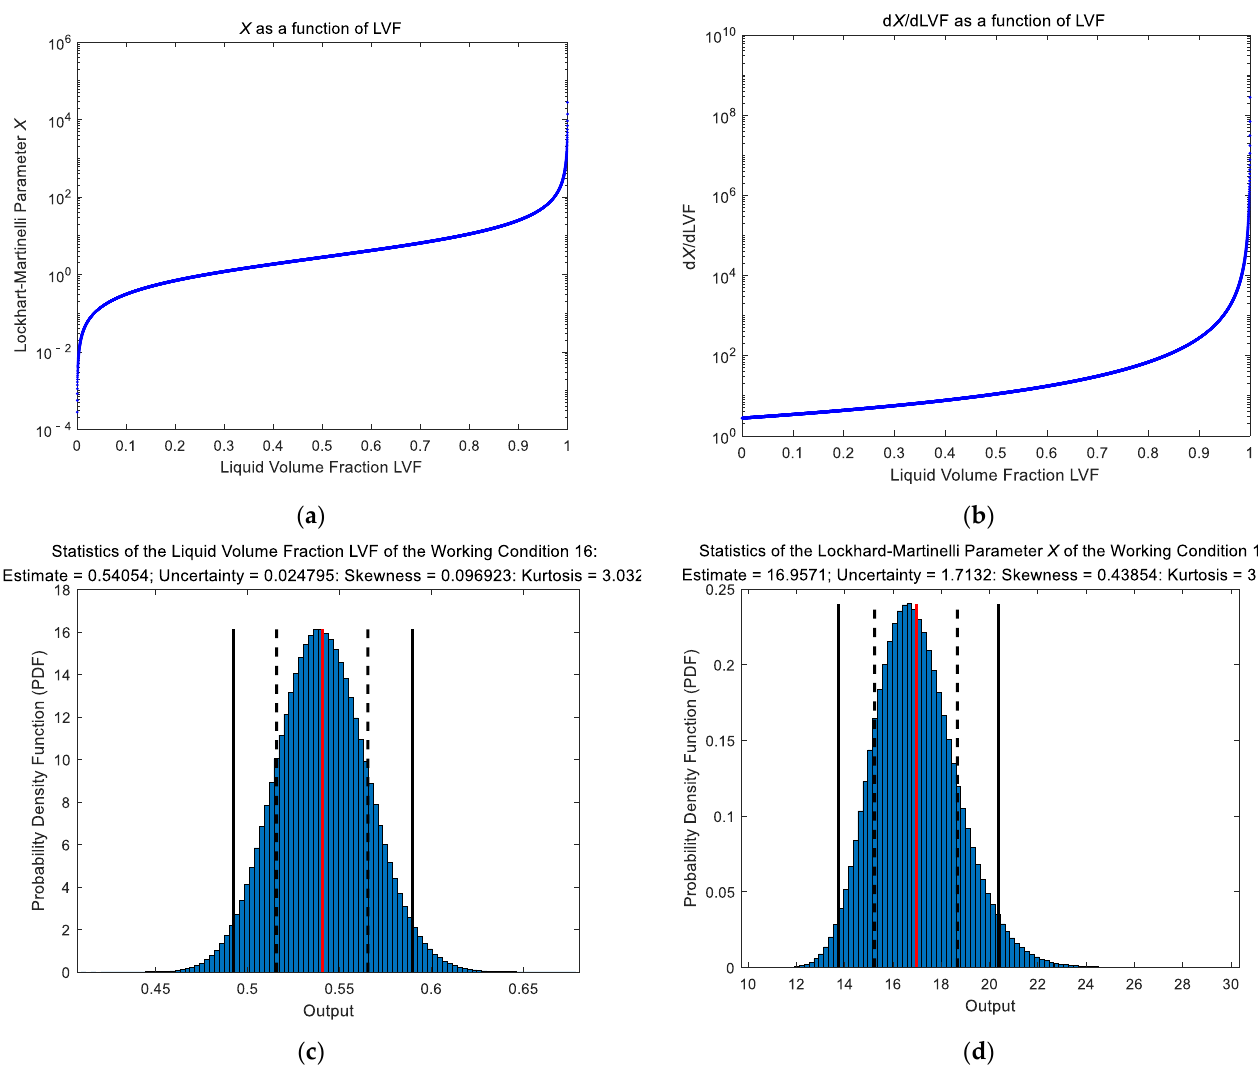
Figure 14. The change of the probability density function (PDF) of the “DP + Cap” method when the liquid volume fraction LVF is converted to the L-M number X : ( a ) X as a function of LVF; ( b ) d X /dLVF as a function of LVF; ( c ) PDF of a certain LVF; ( d ) PDF of the corresponding X